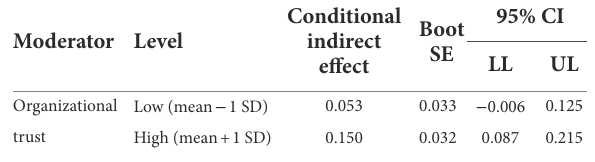
TABLE 7 Moderated mediation effect test.